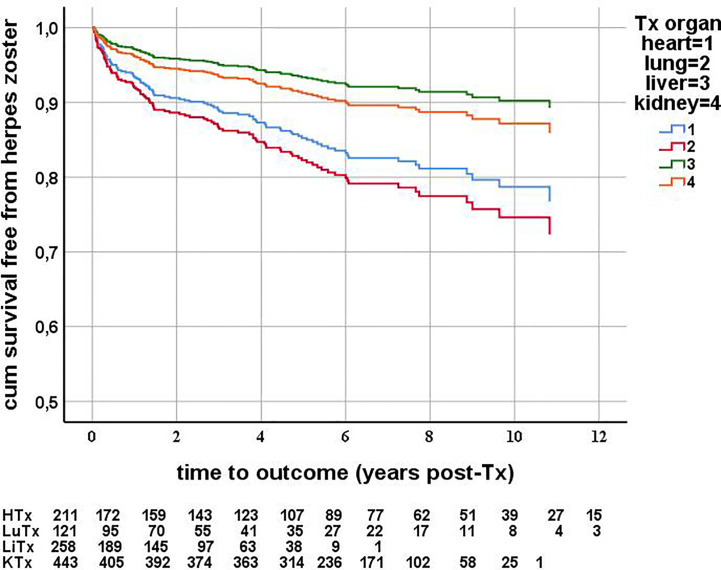
Herpes zoster free survival after solid organ transplantation, censored for death and graft failure. Cox proportional hazards, multivariable analysis. First episodes of herpes zoster were counted as event. Herpes zoster incidence is significantly higher in heart recipients compared to liver (p = 0.011) and kidney (p = 0.034) transplant recipients. For each organ type, the number of patients at risk at each year after transplantation is described below the graph.